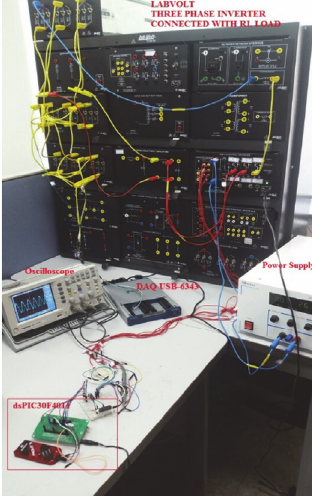
Figure 14: Experimental setup.